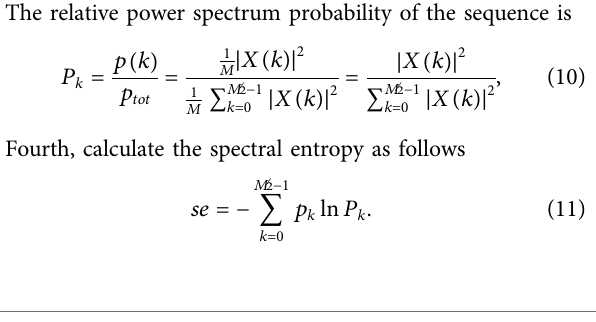
Frontiers in Physics |